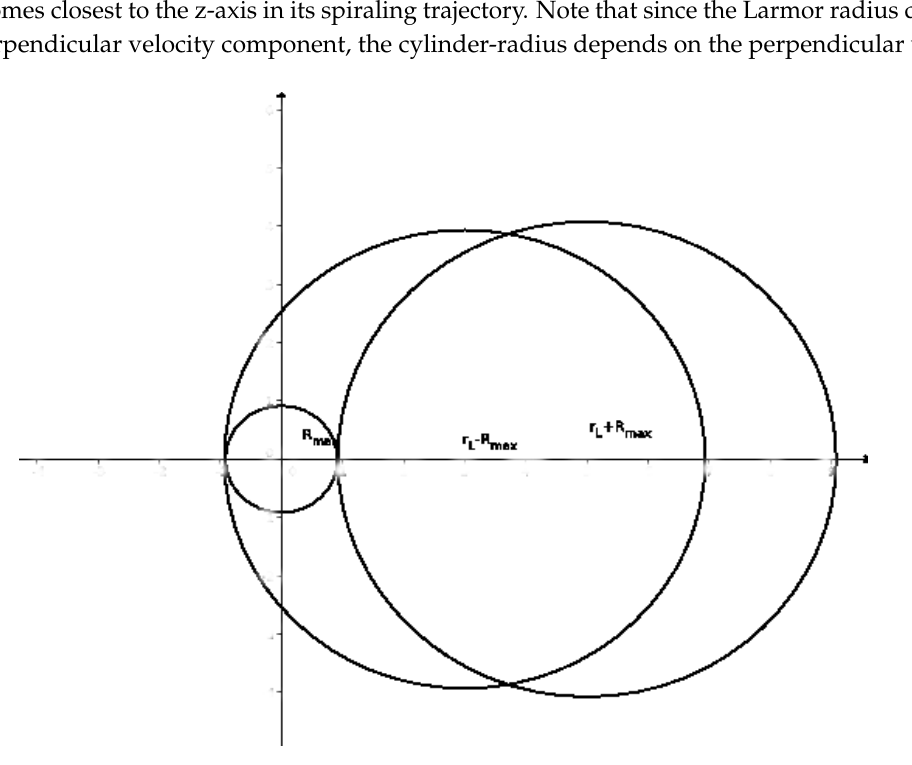
Figure 2. x-y trajectory projections for r L > R max